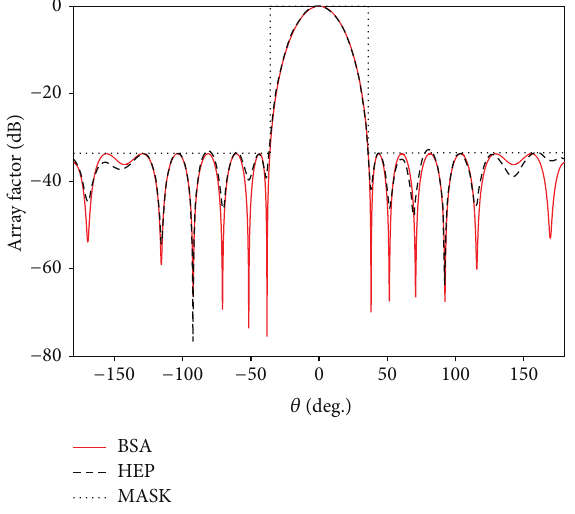
Figure 11: The radiation patterns obtained by BSA and BGA [3] for CCAA without central element.